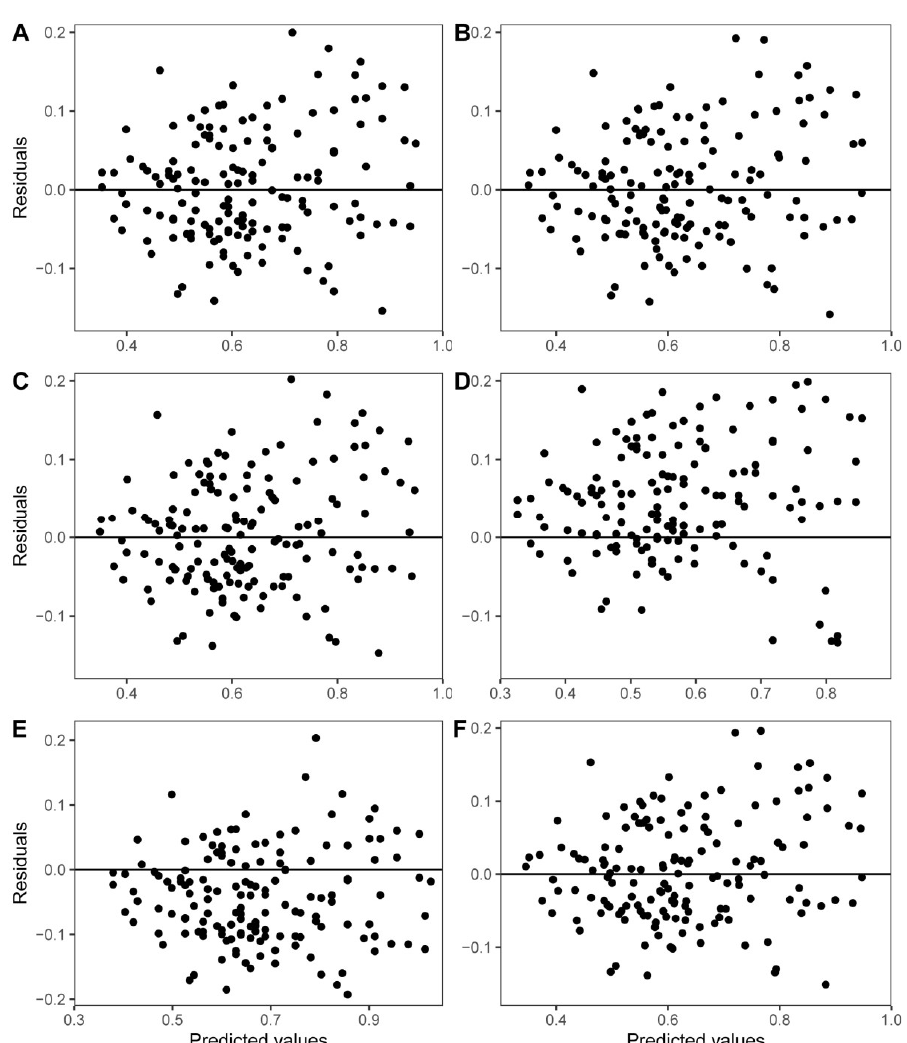
Figure 3. Residuals plots of W1 ( A ), W2 ( B ), W3 ( C ), W4 ( D ), W5 ( E ), and W6 ( F ) of Moso bamboo